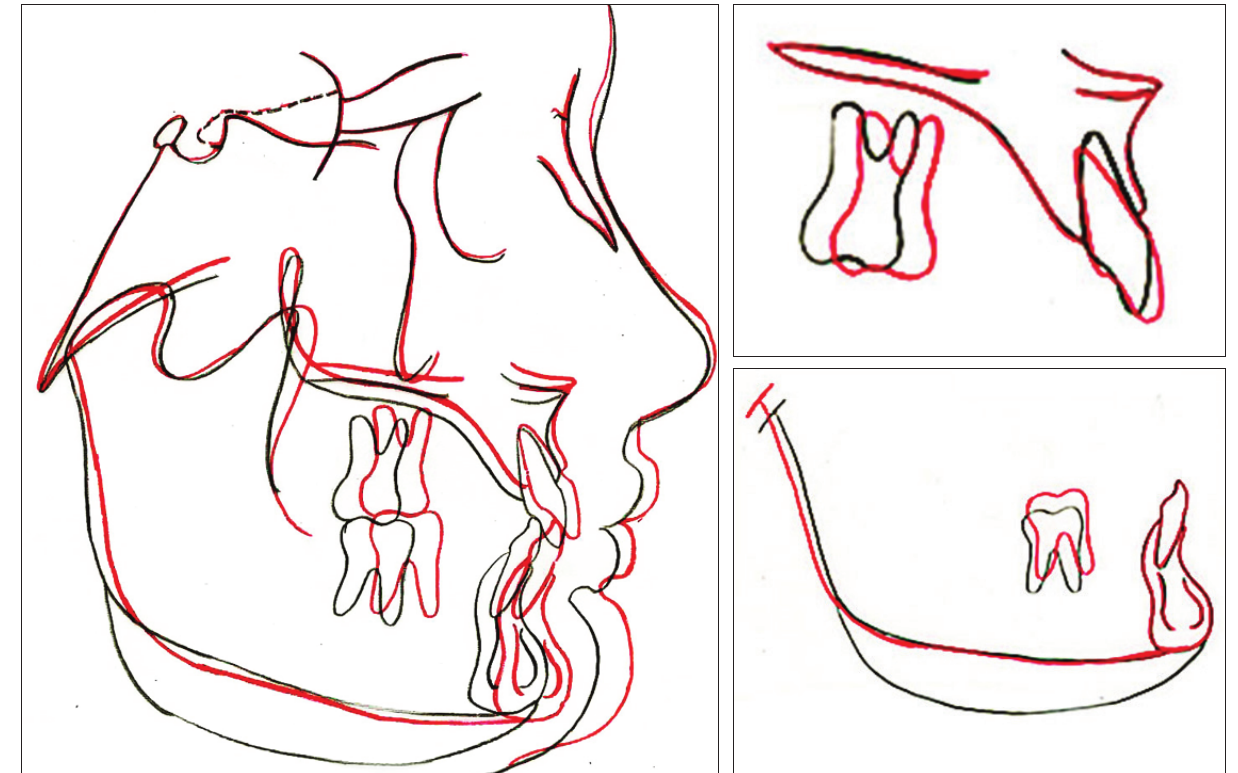
Figure 5a. Pre- to post-treatment